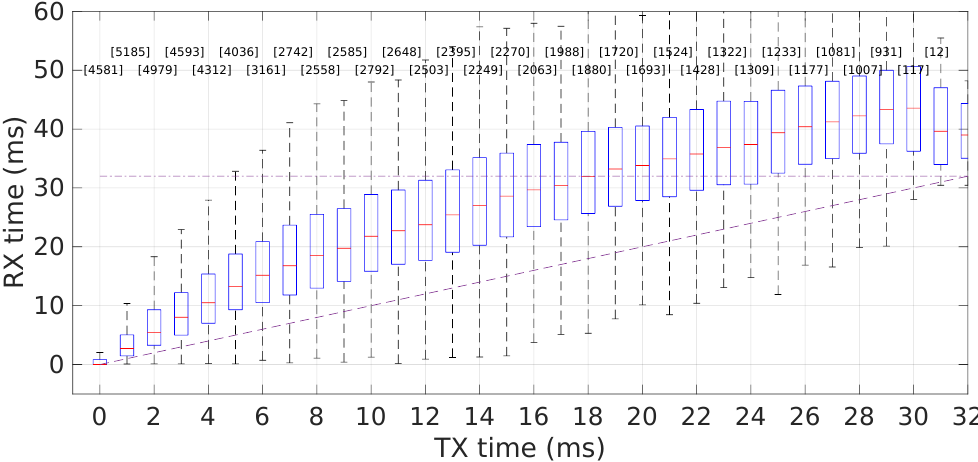
Figure 14. Packet spreading. Packets reception times ( y -axis) as a function of the respective transmission times ( x -axis) in the transmitter slot, at the application layer. Reception times grow visibly along the slot, due to packet accumulation in queues.